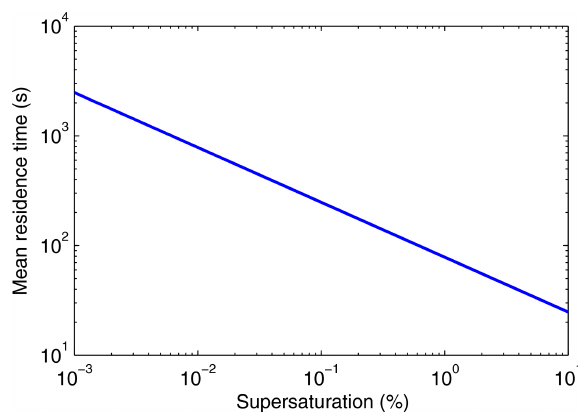
Figure 10. Mean droplet residence time versus supersaturation for h = 1m as given by Eq.